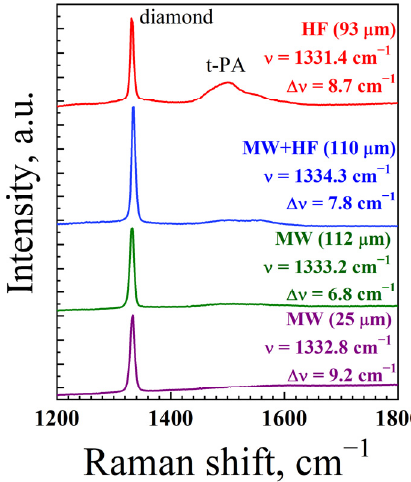
Figure 4. Raman spectra of the CVD-grown PCD samples (from top to bottom): 93 µm-thick HF CVD;